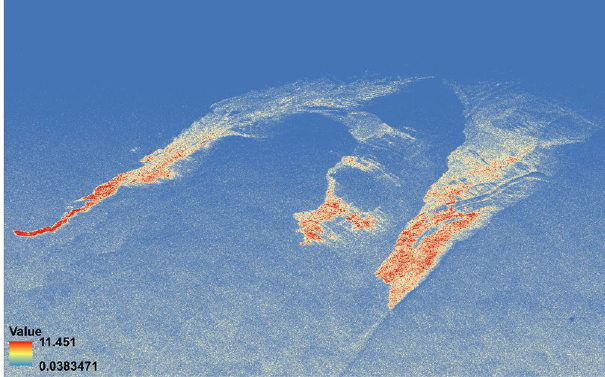
Figure 5. VV damping ratio of the UAVSAR image values ranging from 0.0038 to